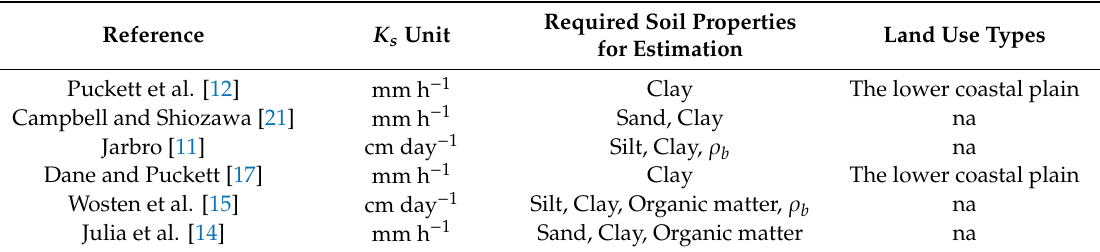
Table 3. Six pedo-transfer functions (PTFs; Equations (S1)–(S6)) of previous research used for estimating the saturated hydraulic conductivity and their required soil properties.